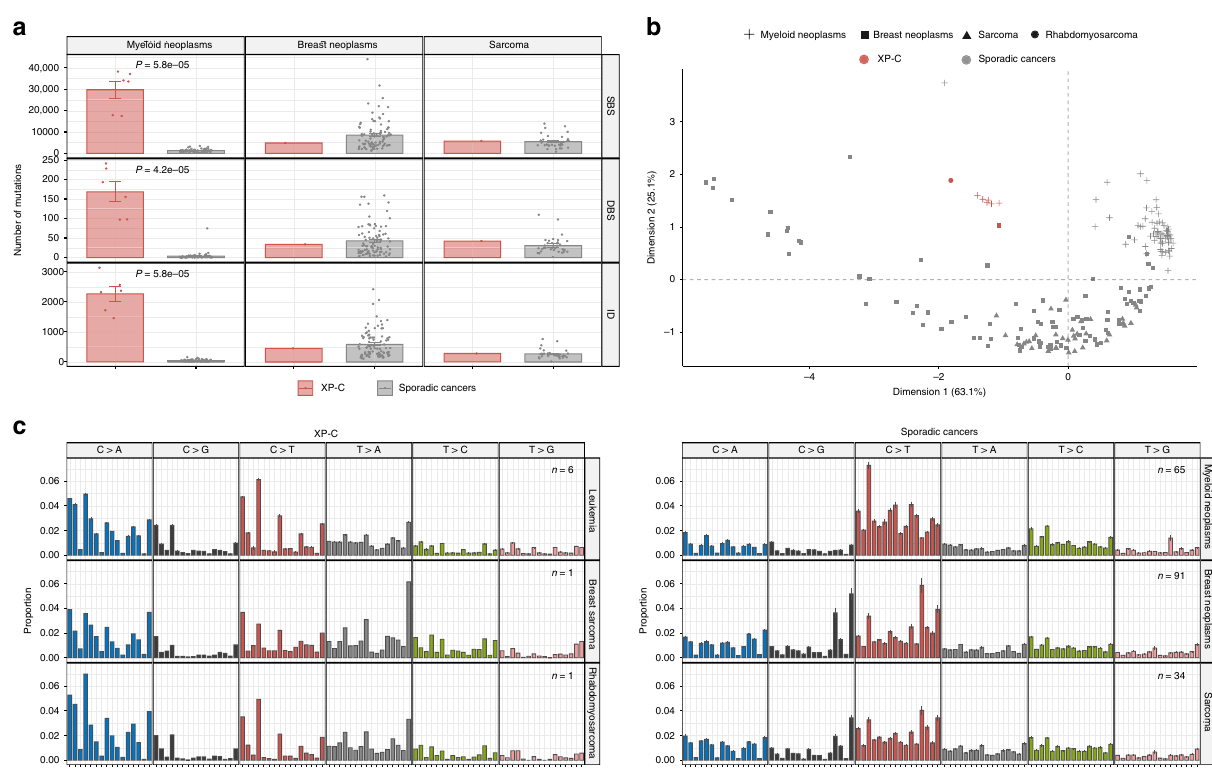
Fig. 1 Mutational load and pro fi les of XP-C and 190 tissue-matched sporadic cancers. a Number of SBS (single base substitutions), DBS (double base substitutions) and ID (indels) in XP-C and sporadic cancers with indicated SEM intervals. The difference is highly signi fi cant for myeloid neoplasms (Mann – Whitney U test, two-sided, n = 6 for XP-C and n = 65 for myeloid neoplasms), but number of mutations in breast sarcoma ( n = 1) and rhabdomyosarcoma ( n = 1) are in the range of sporadic tumors ( n = 91 and n = 34 for breast cancer and sarcoma respectively). b Multidimension scaling plot based on the Cosine similarity distance between the mutational pro fi les of the samples. XP-C tumors clearly groups together and are distant from tissue-matched sporadic cancers. c Trinucleotide-context mutational pro fi les (SEM intervals are shown in case of multiple samples, n represents the number of independent cancer samples). An x -axis represents the nucleotides upstream and downstream of mutation. XP-C tumors demonstrate high similarity with each other (left panel), but pro fi les of sporadic cancers (right panel) are different from